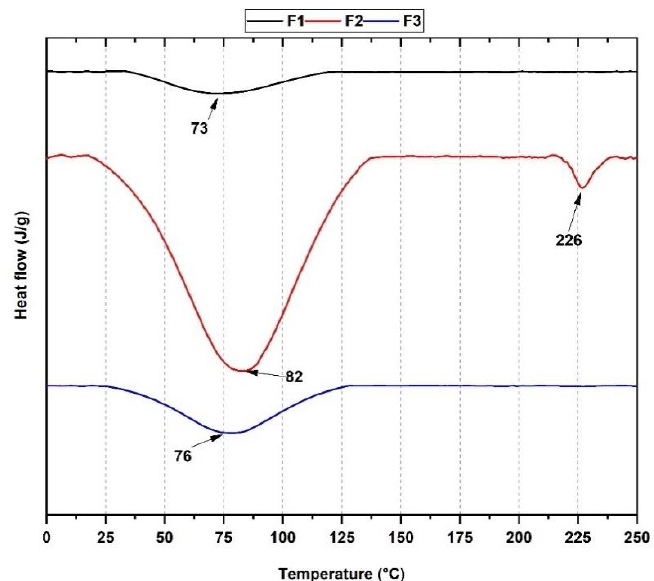
Figure 3. DSC thermograms for F1, F2, and F3. According to Table 1, F1: InterOss. F2: InterOss Collagen. F3: InterCollagen Guide.